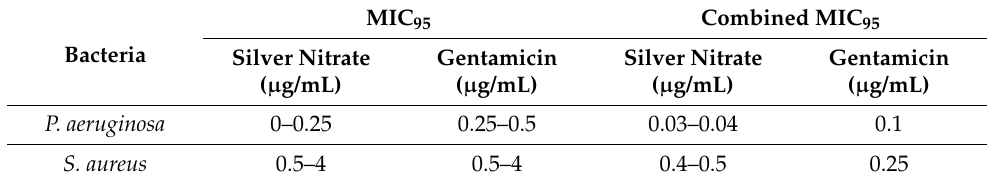
Figure 1. Bacterial concentration at t = 4 h for ( a ) AgNO 3 against S. aureus , ( b ) gentamicin against S. aureus, ( c ) AgNO 3 against P. aeruginosa , ( d ) gentamicin against P. aeruginosa . Table 1. MIC 95 values for silver nitrate, gentamicin or combinations against P. aeruginosa and S. aureus.